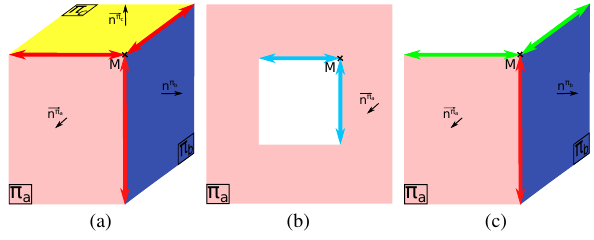
Figure 9. Kinds of possible corners. (a) intersection of three planes ; (b) intersection of two coplanar straight lines ; (c) intersection of three straight lines.